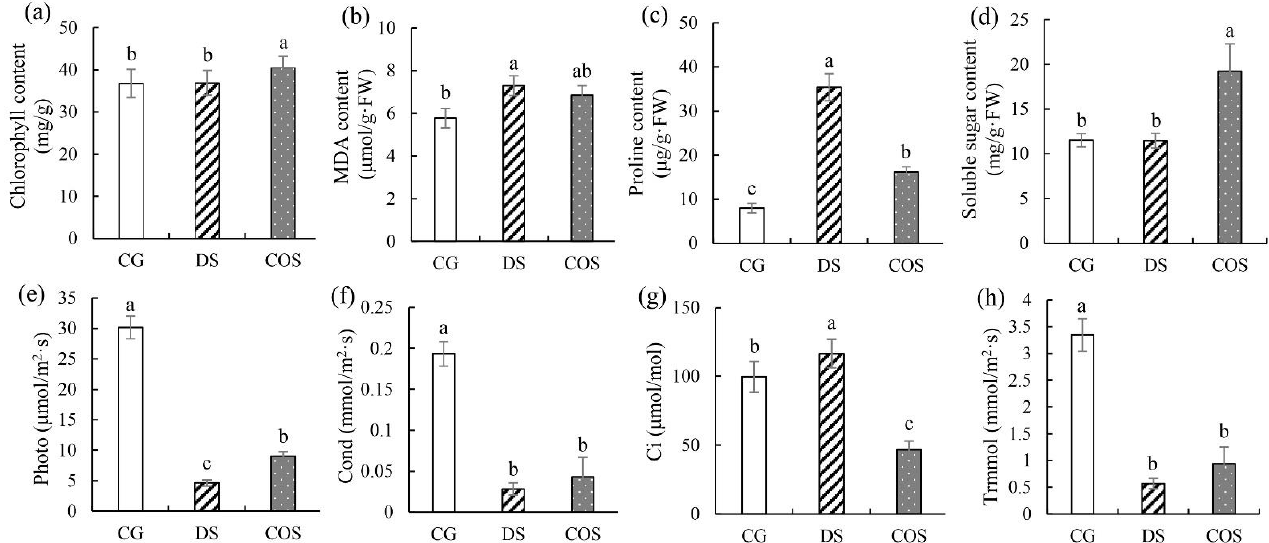
Figure 1. Physiological and biochemical parameters under different treatments. (a) Variation diagram of chlorophyll con- tent. (b) Variation diagram of malondialdehyde (MDA) content. (c) Variation diagram of proline content. (d) Variation diagram of soluble sugar content. (e) Variation diagram of Photo. (f) Variation diagram of Cond. (g) Variation diagram of Ci. (h) Variation diagram of Trmmol. Photo, Cond, Ci, and Trmmol indicate net photosynthesis, stomatal conductance, intercellular carbon dioxide concentration, and transpiration rate, respectively. Error bars represent standard deviation of three samples. Different letters on bars indicate statistically significant differences between treatments ( p < 0.05).